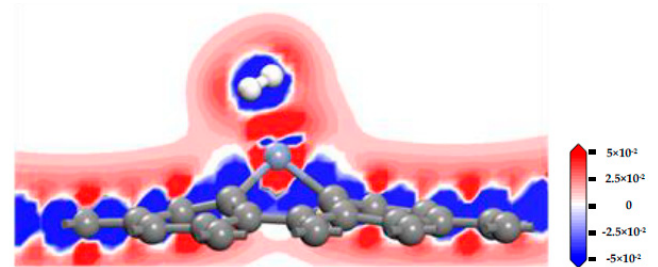
Figure 9. The charge density difference of CrG system.